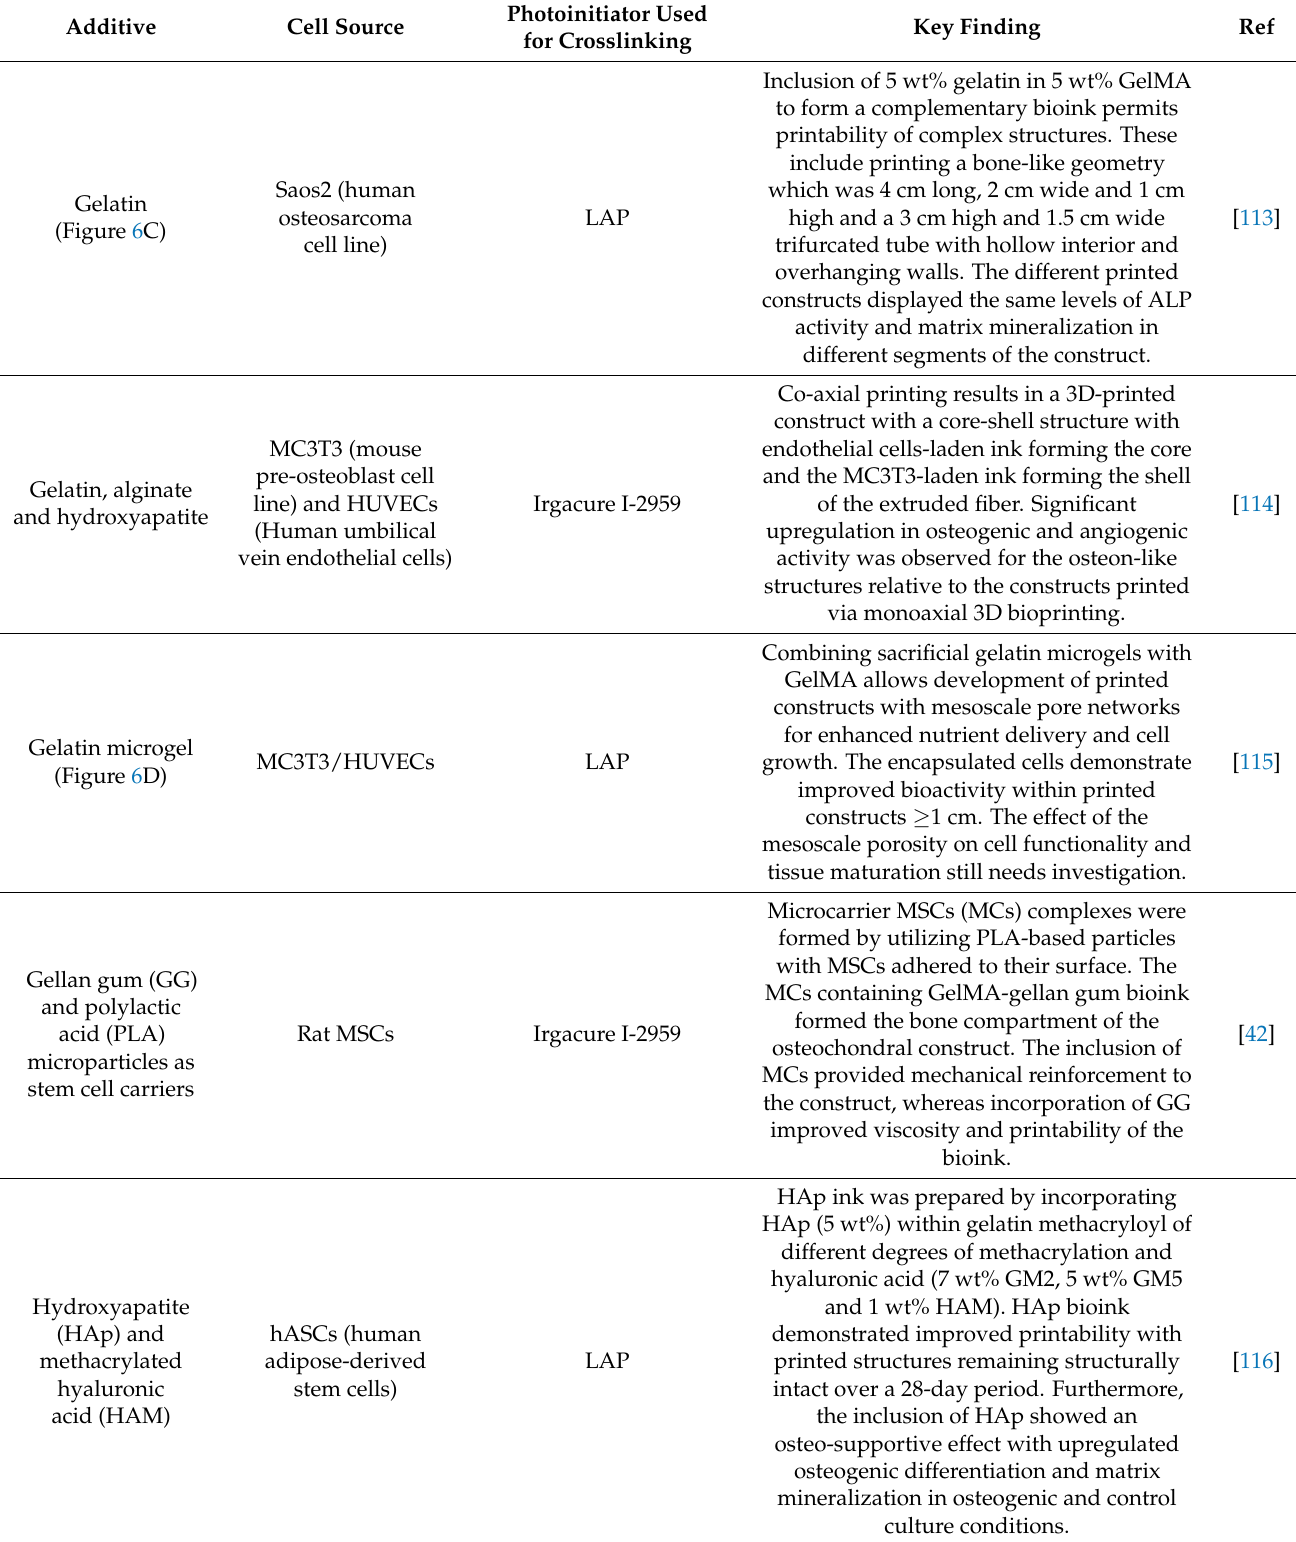
Table 2. Polymeric and bioactive additives for bioprinting GelMA for bone